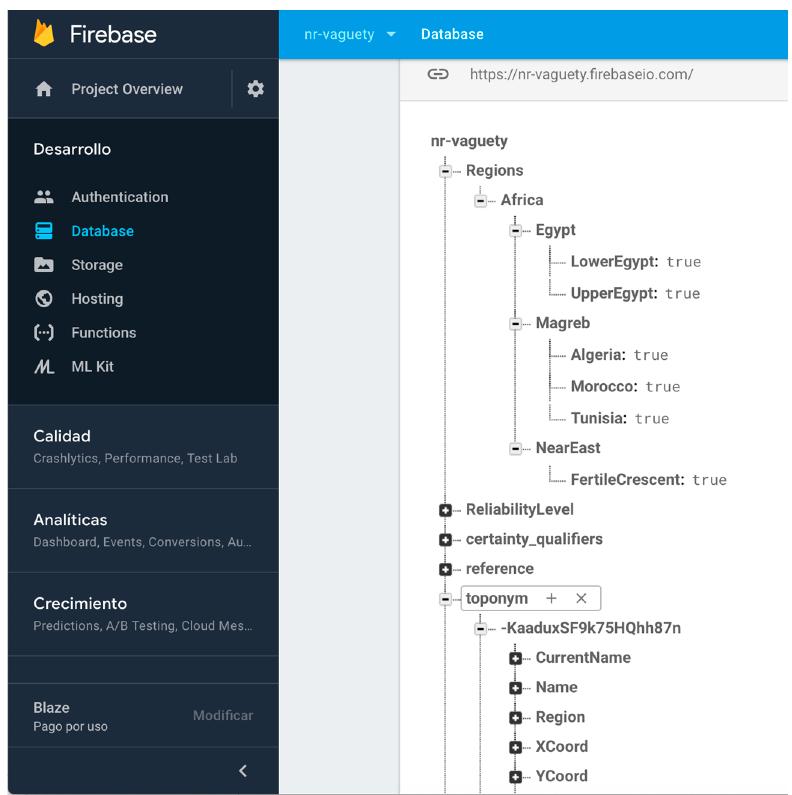
Figure 5. Firebase console showing the regions data node implementing the abstract enumerated items mechanism.